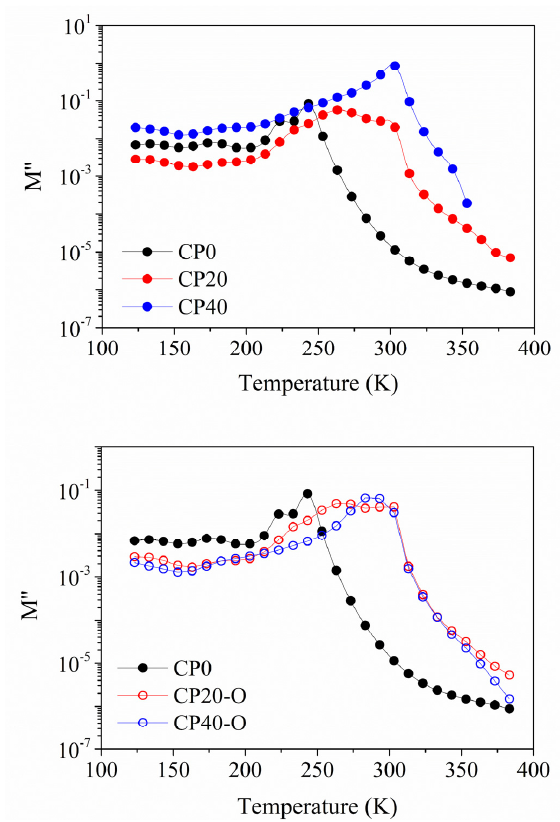
Figure 6. Isochronal curves for the imaginary part of the complex modulus ( M* ) at a frequency of 10 − 1 Hz ( Top ) for the neat and unoriented membranes; ( Bottom ) for the neat and oriented mem- branes.